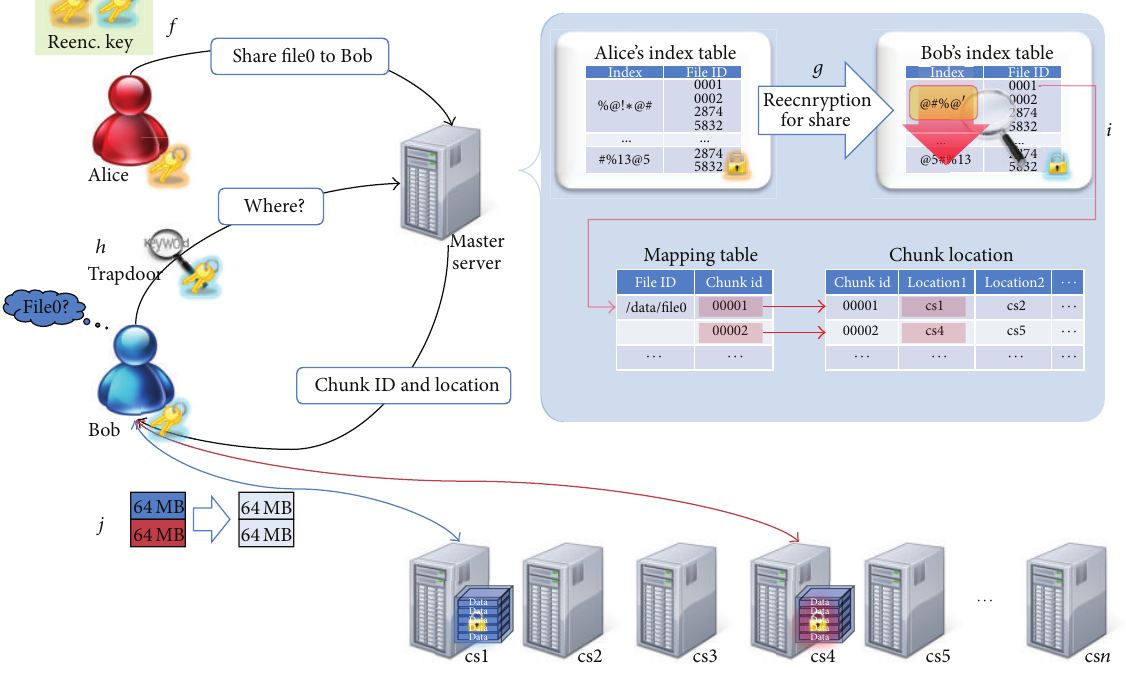
Figure 6: Sharing